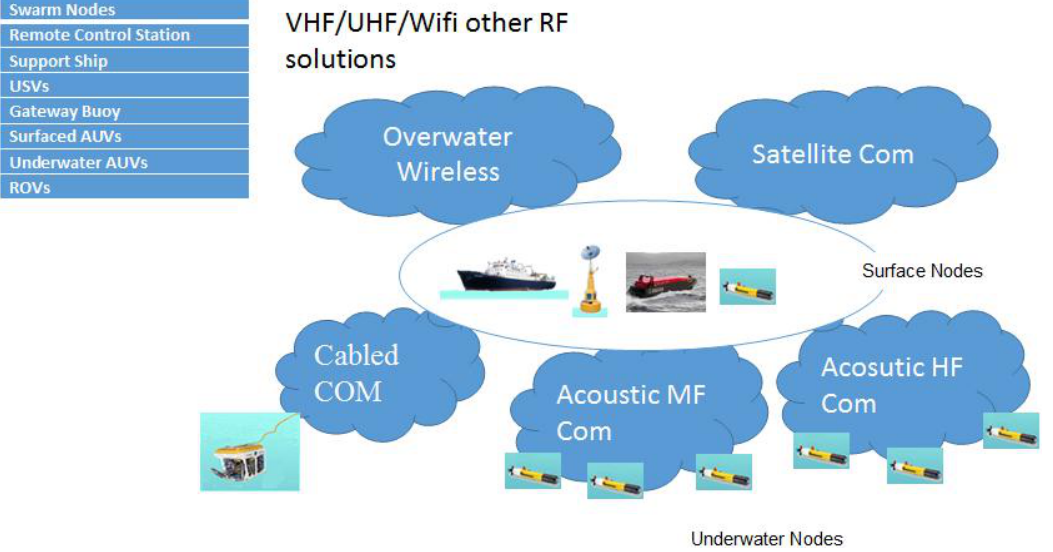
Figure 1. The architecture of the communication network in SWARMs project.